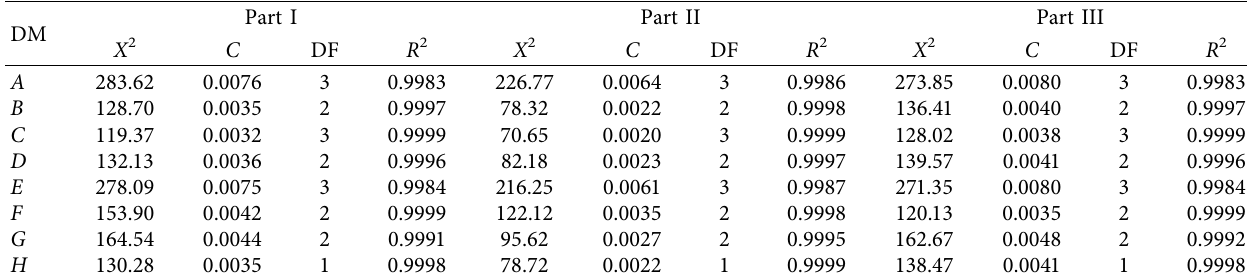
Table 3: Using the Altmann-Fitter to fit the static word-length distribution data of the three parts of DRC.